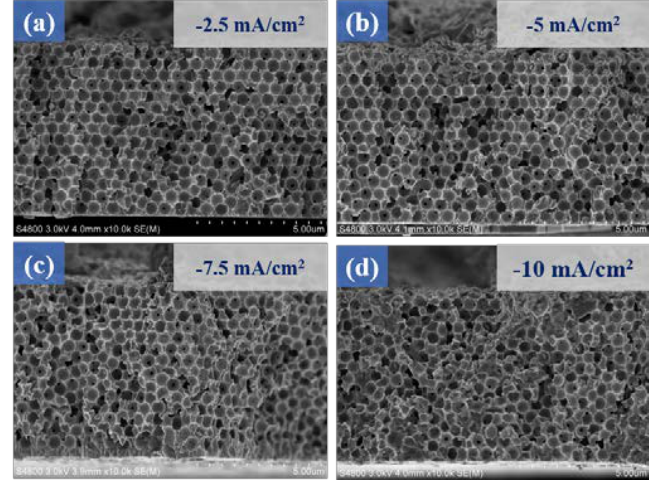
Figure 8. Cross-sectional micrographs of the MnS/MoS 2 /Ni − IOS microelectrode samples fabricated with different electrodeposition densities. The current densities were ( a ) − 2.5 mA/cm 2 , ( b ) − 5 mA/cm 2 using the 10 min electrodeposition parameters of MnS, ( c ) − 7.5 mA/cm 2 , and ( d ) − 10 mA/cm 2 , respectively.